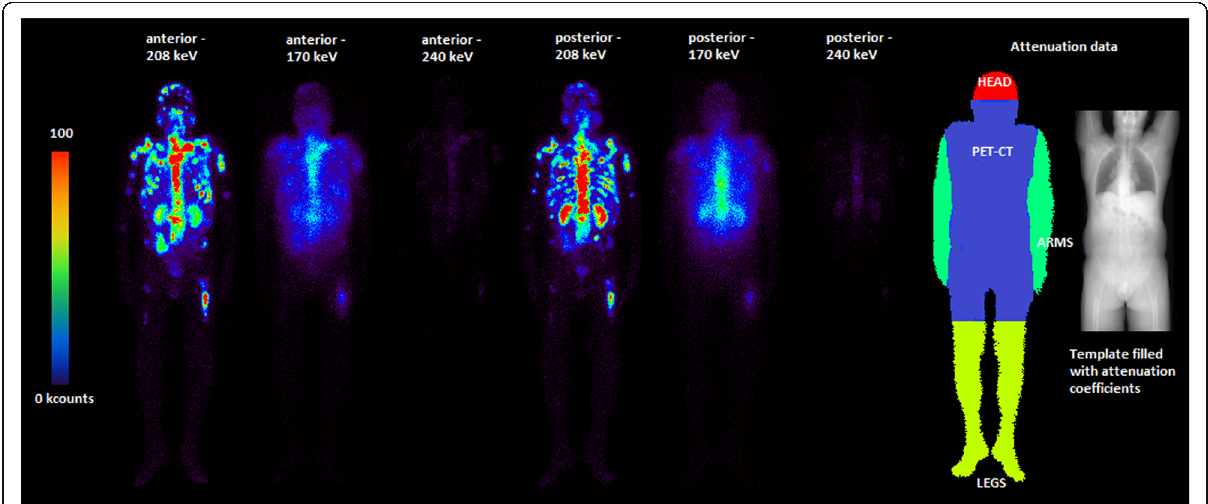
Fig. 1 Workflow for planar image quantification shown for patient P8. Anterior and posterior views for all three energy windows (24 h p. i.; photopeak and both scatter windows) and attenuation map based on the projected patient-specific CT from the PET/CT